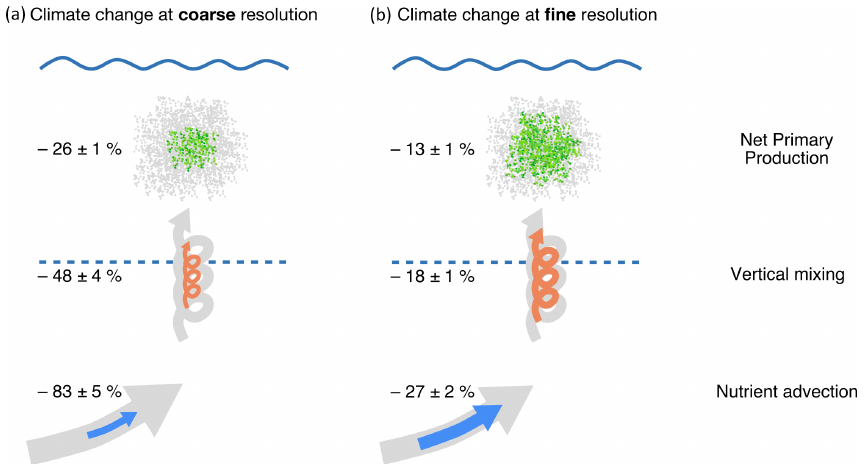
Figure 7. Schematic representation of the projected response of net primary production (NPP) and of the nutrient fluxes (advection and vertical mixing) supporting it to warming, with our (a) eddy-parameterized coarse-resolution (1 ◦ ) and (b) eddy-resolving fine-resolution (1 / 9, 1 / 27 ◦ ) simulations, in the model’s subpolar gyre. Decline in nutrient advection is assessed from changes between the surface and 200m depth (Tot. trp. in Fig. 4). Decline in vertical mixing is evaluated at 25m depth, which is where the decrease is maximal. NPP change is vertically integrated over the entire water column. Changes at the coarse resolution are the average of the five 1 ◦ configurations ± 1 standard deviation. Changes at the fine resolutions are the average of the 1 / 9 and 1 / 27 ◦ configurations ± half of the difference between the two. The background diagrams in gray represent the initial control situation, while the colored diagrams represent the situation after 70 years of